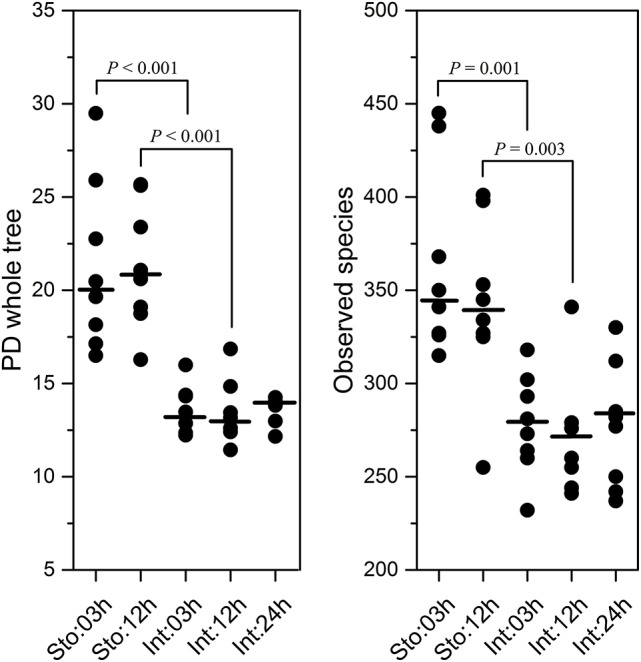
Diversity and species richness estimation of stomach and intestine microbiota of southern catfish after feeding. Phylogenetic diversity (PD) whole tree and observed species measurements calculated after rarifying samples to equal sequencing depth in QIIME.